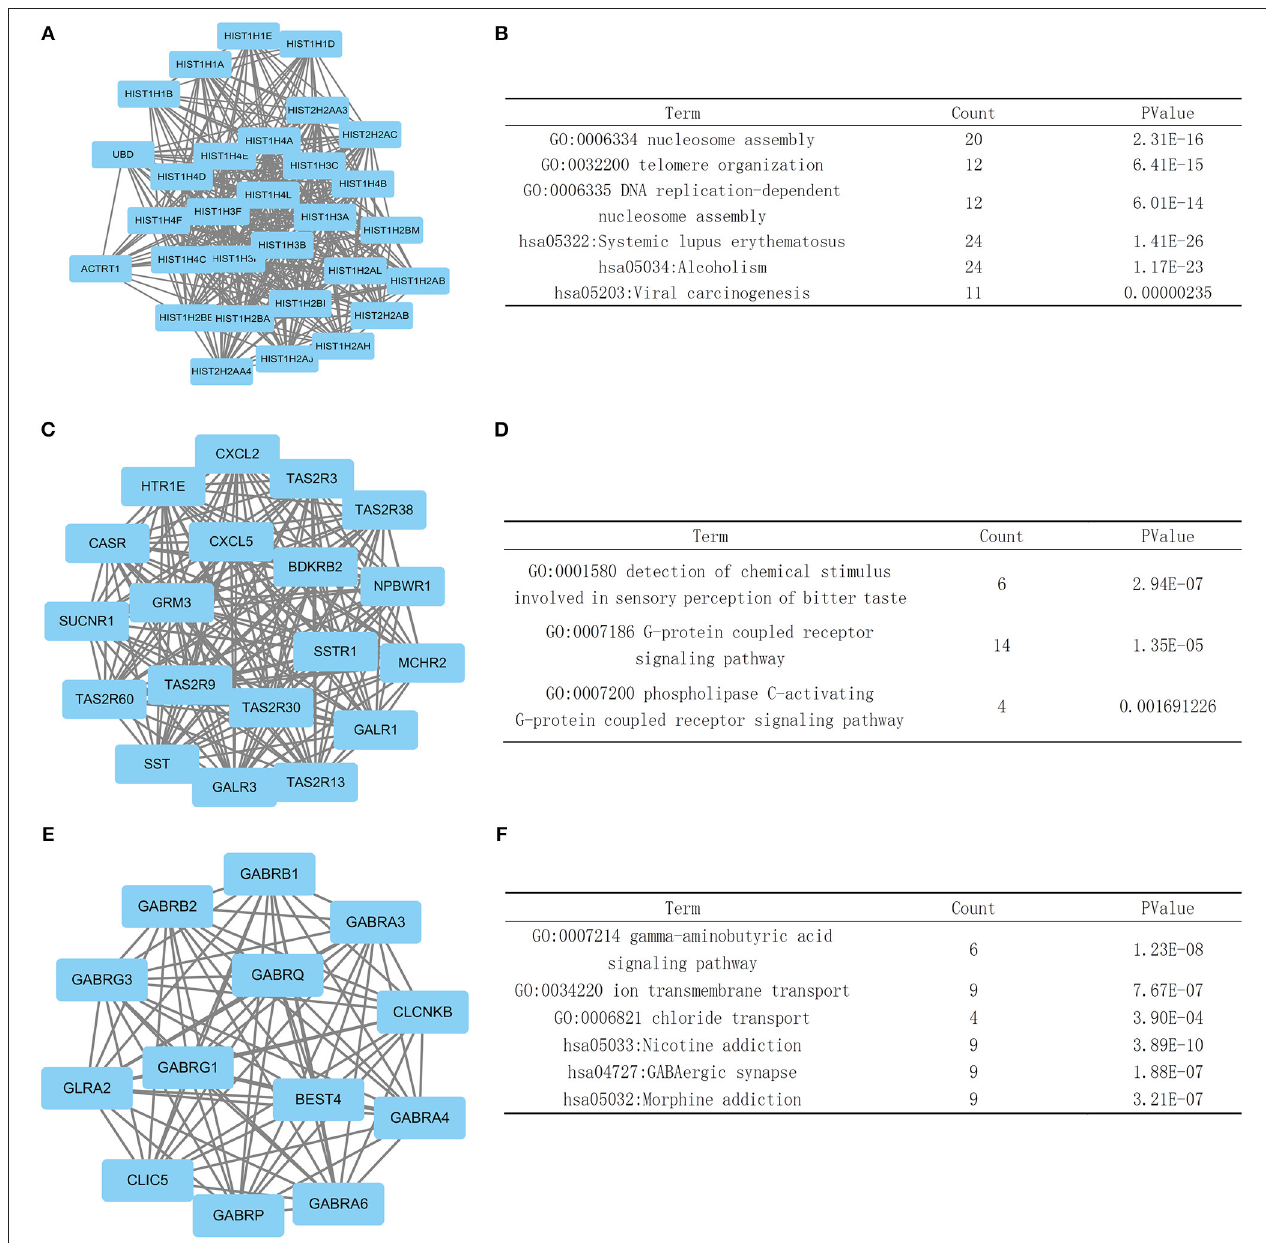
FIGURE 5 | Top three modules from the PPI network. (A,B) PPI network and GO and KEGG analyses of module 1. (C,D) PPI network and GO and KEGG analyses of module 2. (E,F) PPI network and GO and KEGG analyses of module 3.